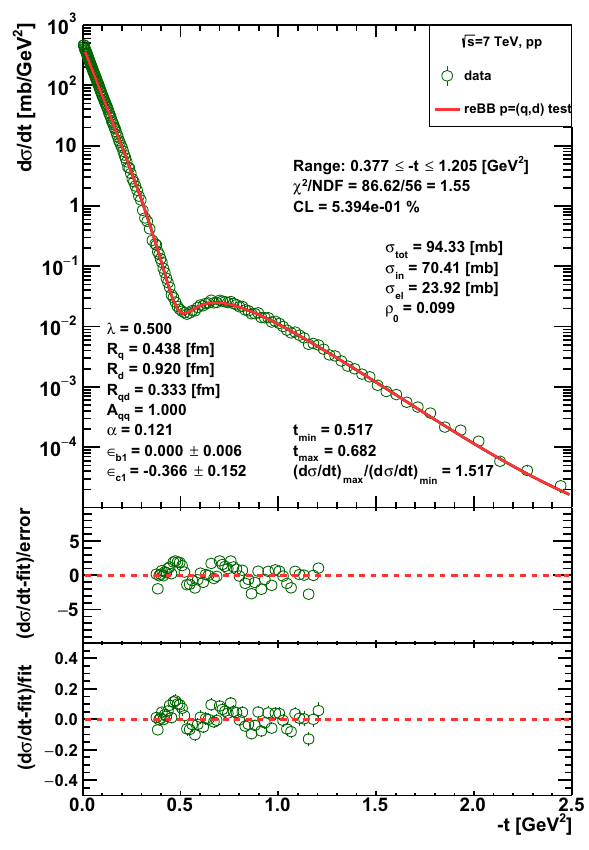
Fig. 13 Result of a sanity test, same as Fig. 8, but for the pp elastic √ s = 7 TeV from Ref. [47], in the differential cross section data at fitted range of 0 . 37 ≤ − t ≤ 1 . 2 GeV 2